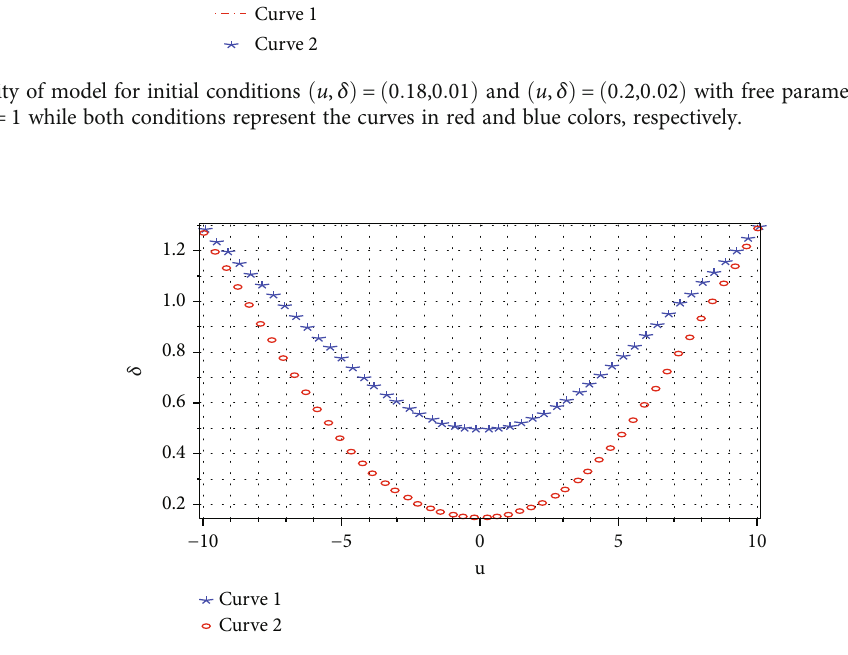
Figure 14: Sensitivity of model for initial conditions ð u , δ Þ = ð 0 : 5,0 : 001 Þ and ð u , δ Þ = ð 0 : 15,0 : 001 Þ with free parameters S = 1 , T = − 2 , V = 1 , κ = 2 , l = 1 , and β = 1 while both conditions represent the curves in red and blue, 1